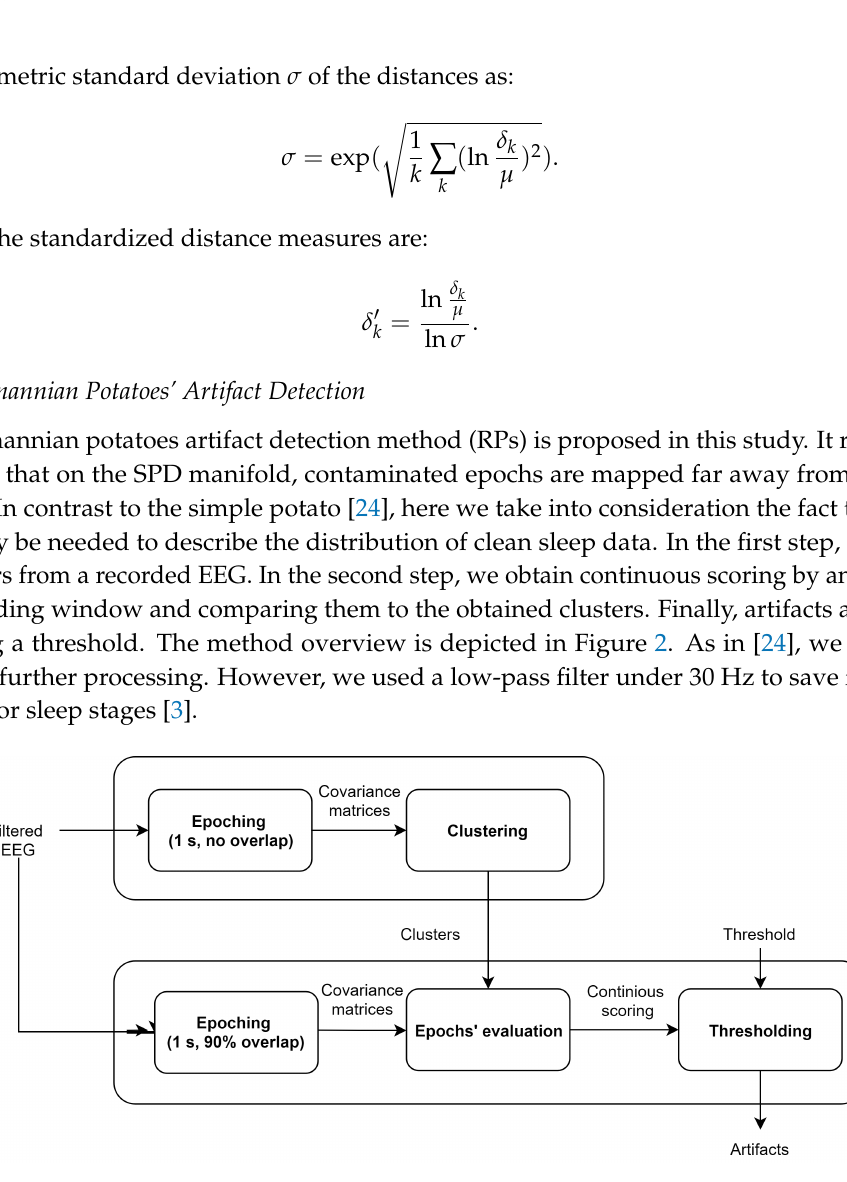
Figure 2. The method